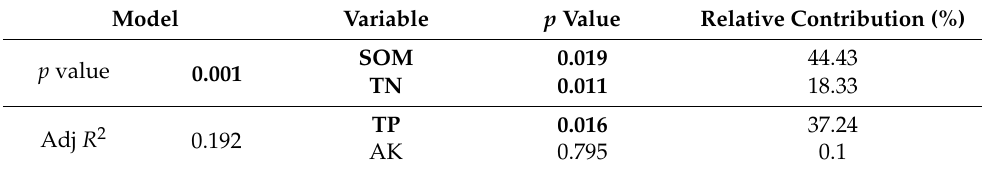
Table 3. The contributions of soil chemical properties to the variation of AMF community. Model Variable p Value Relative Contribution (%)